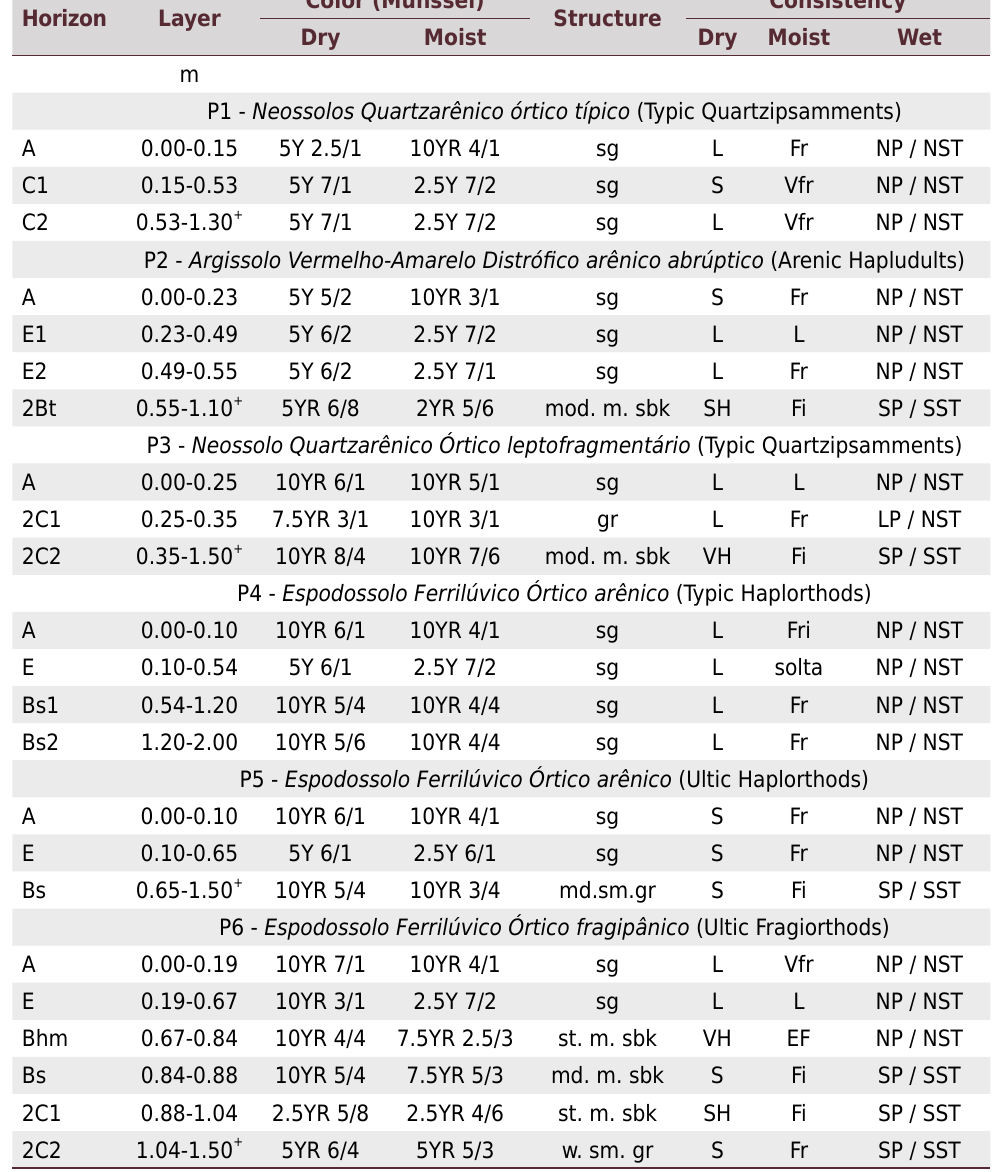
Table 2. Morphological properties of soils in Barreiras Formation and Post-Barreiras environments, Bahia, Brazil